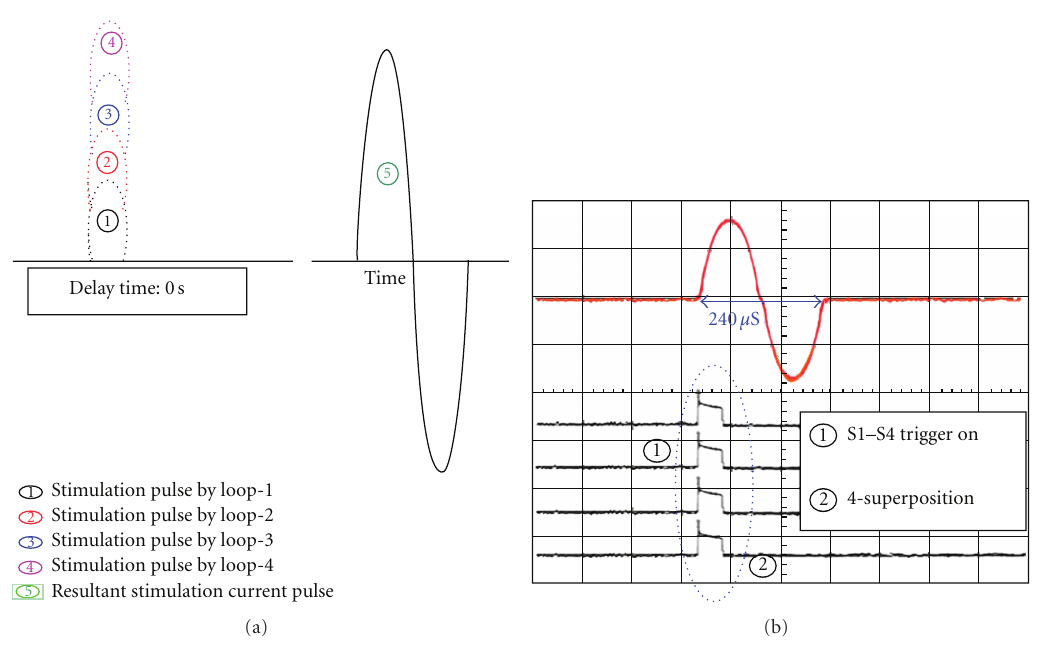
Figure 3: (a) Idea, (b) test. S1, S2, S3, S4: trigger on (delay: 0 s; pulse width: 240 μ